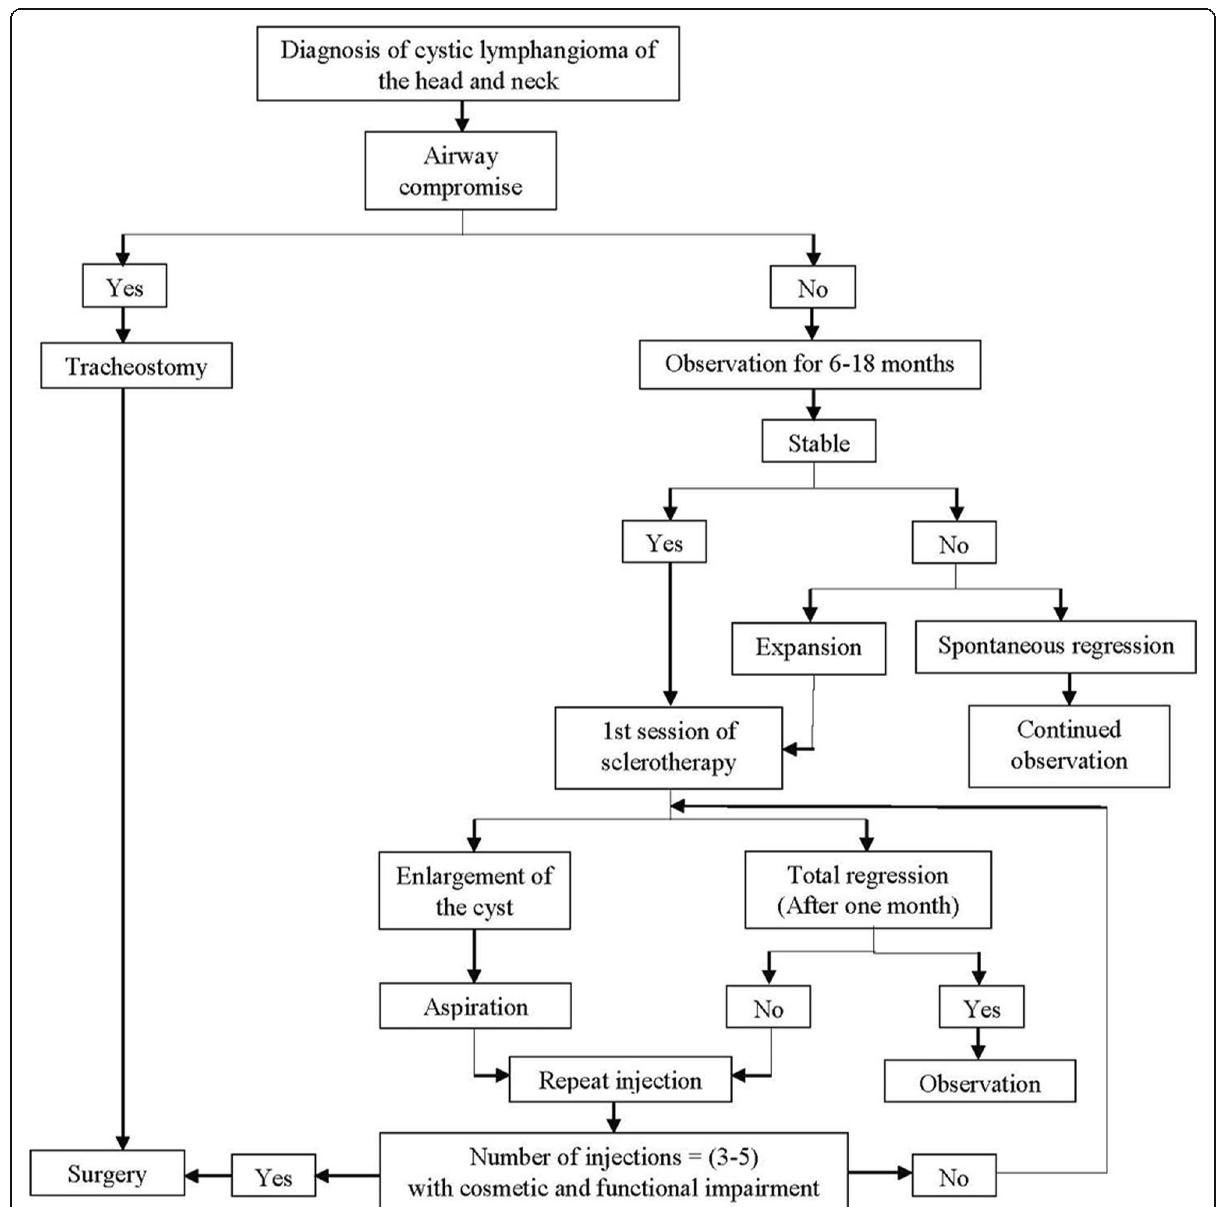
Fig. 5 Proposed decision algorithm management of cystic cervicofacial